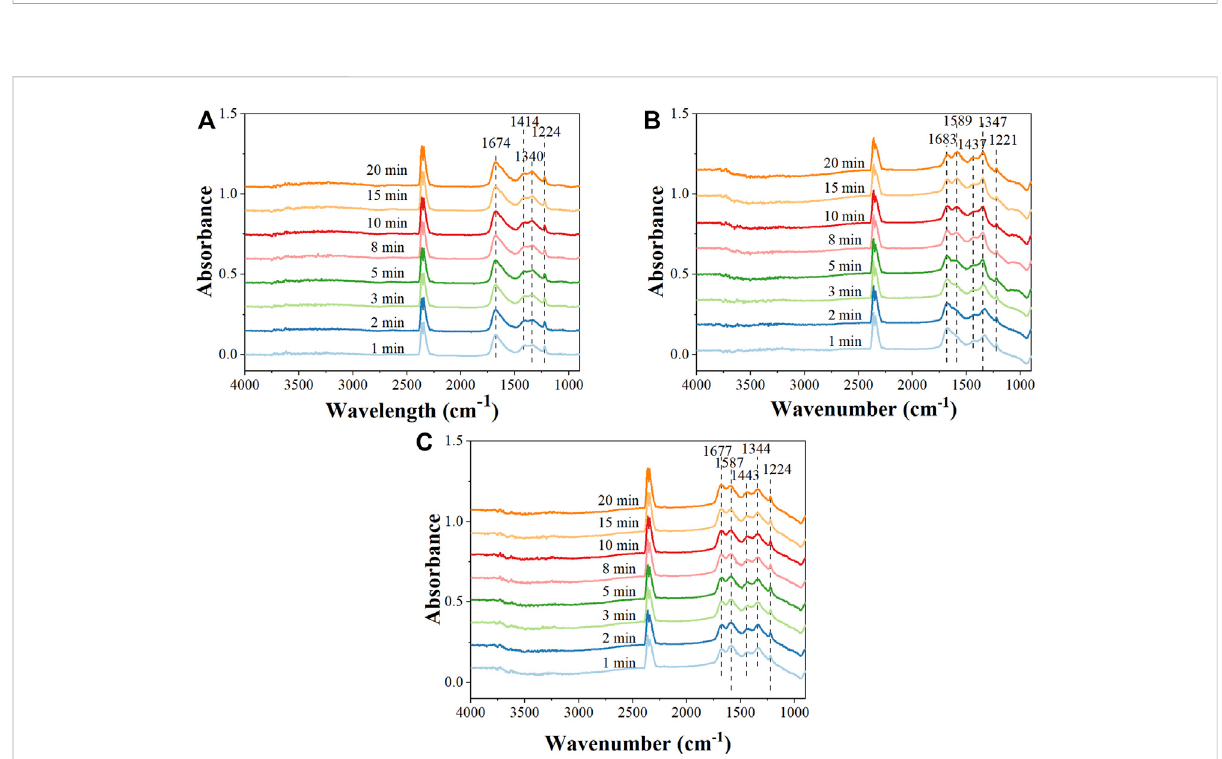
FIGURE 8 In situ DRIFTS spectra of surface species on the 10Ni/MgAl catalyst under (A) the gas feed with plasma-off condition, (B) the gas feed and plasma-on condition (5 kV, 27.2 kHz) and (C) the plasma-off condition after the reaction (feed: 2% CO 2 + 8% H 2 +